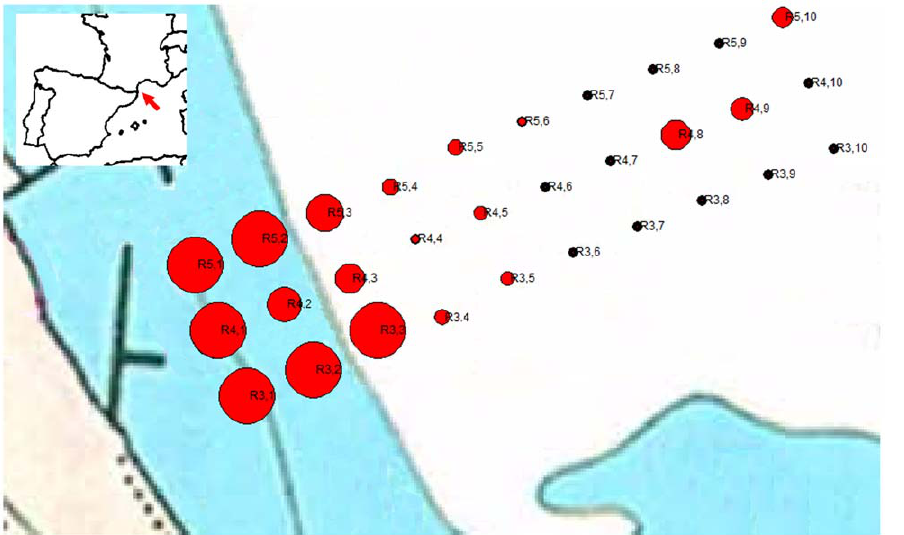
Figure 1. Study area showing the position of the sampling stations. The inset map shows the location of the sampling stations in the Racou beach, France. The size of each red circle is proportional to the density of amphioxus individuals (in ind./l). Stations predominantly composed by silt with a total absence of amphioxus individuals are shown as black dots.